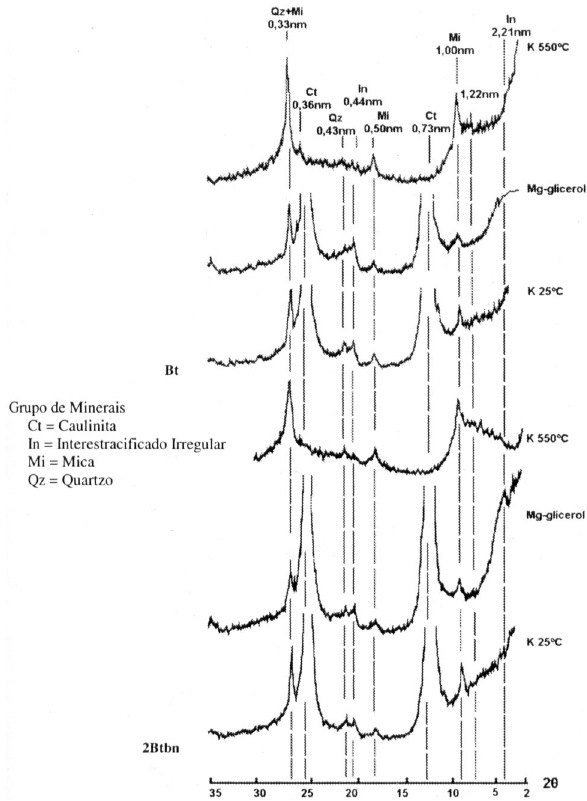
Figura 5. Difratogramas de raios X da fração argila do Perfil 3 - Argissolo Amarelo eutrófico plíntico planossólico